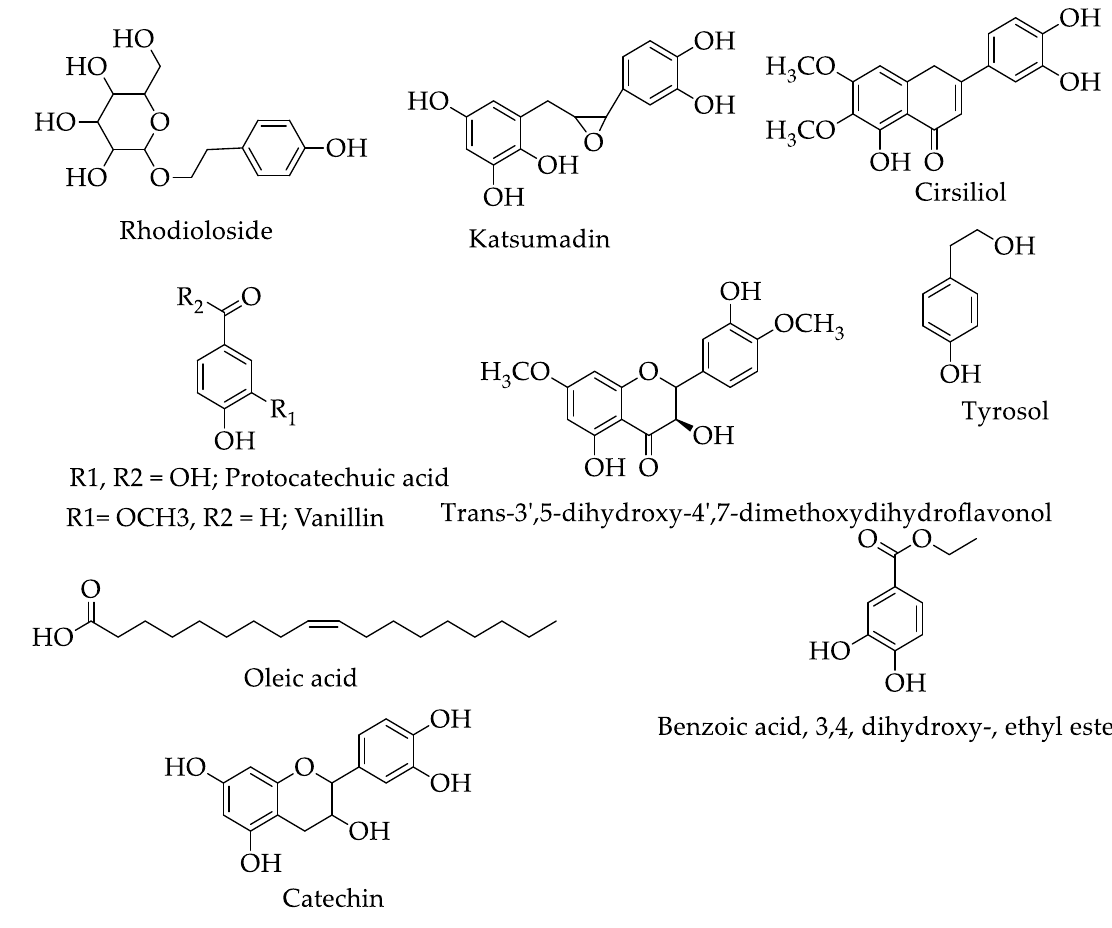
Figure 7. Chemical structures of isolated compounds from H. abyssinica.